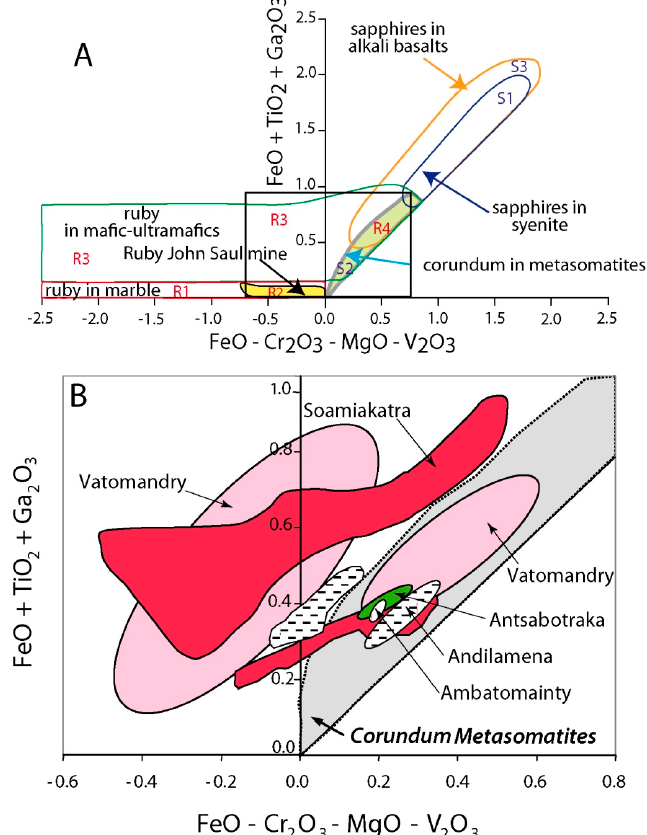
Figure 53. ( A ) Chemical diagram FeO-Cr 2 O 3 -MgO-V 2 O 3 versus FeO + TiO 2 + Ga 2 O 3 showing the